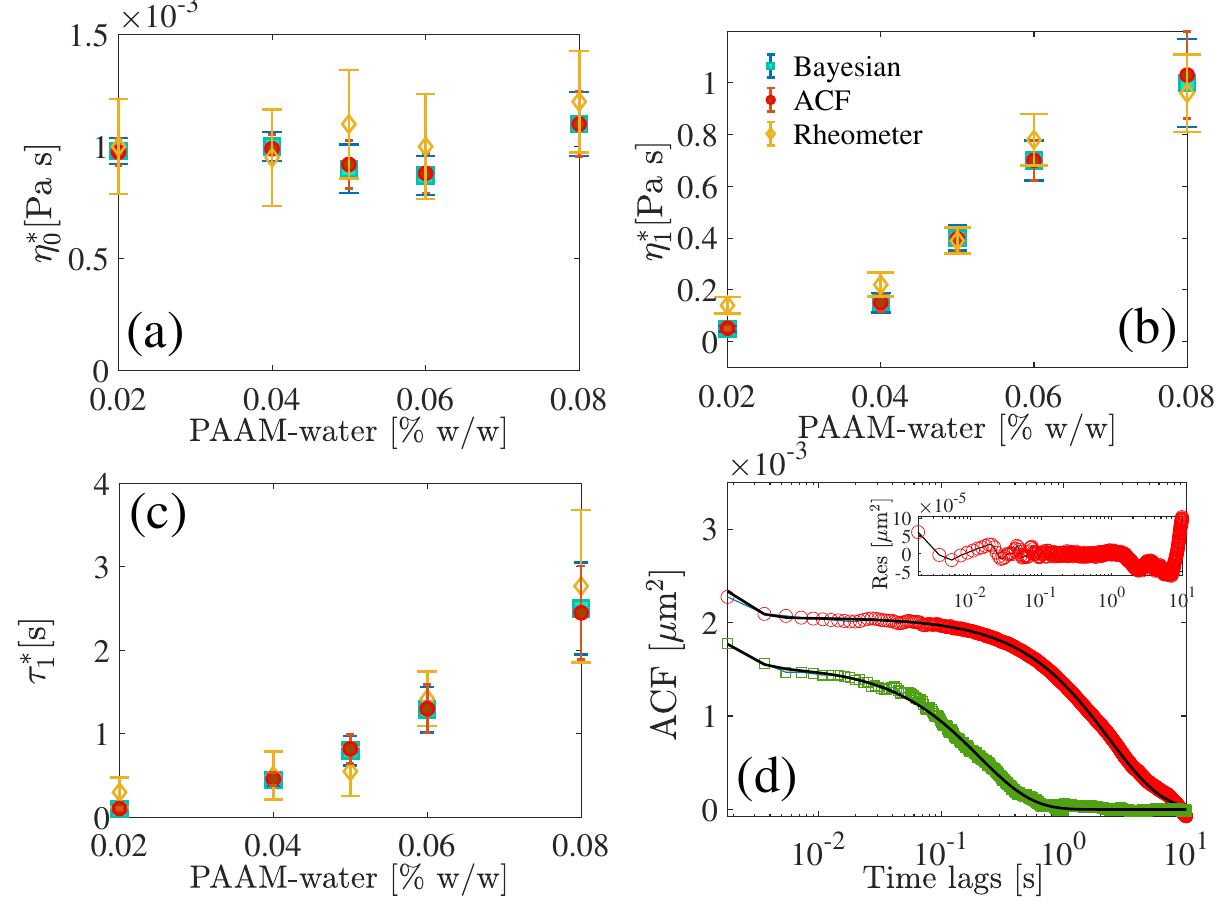
Figure 5. ( a )–( c ) Estimated parameters for various concentration of water PAAM solution. ( d ) ACFs for PAAM-water concentrations 0.02% w/w (green squares) and 0.06% w/w (red circles). (inset) Residue of the fitting for 0.06% w/w PAAM-water concentration. The black lines represent the best